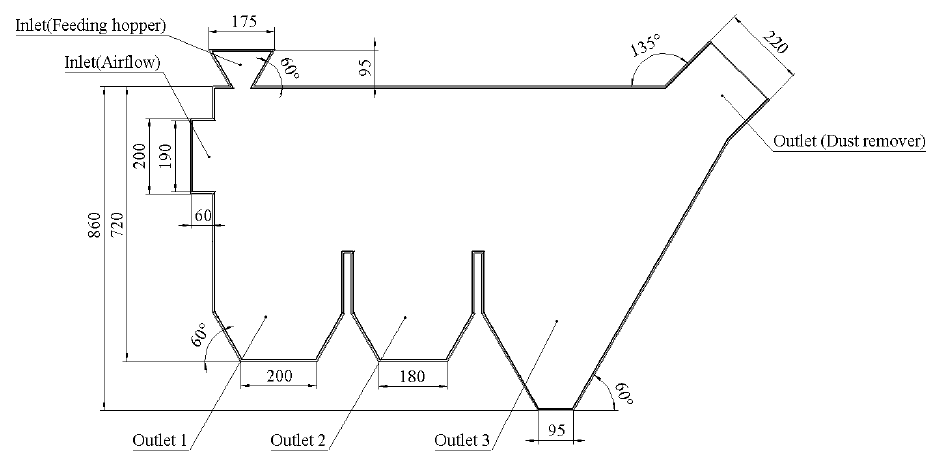
Figure 4. Dimensions of air-separating device unit.